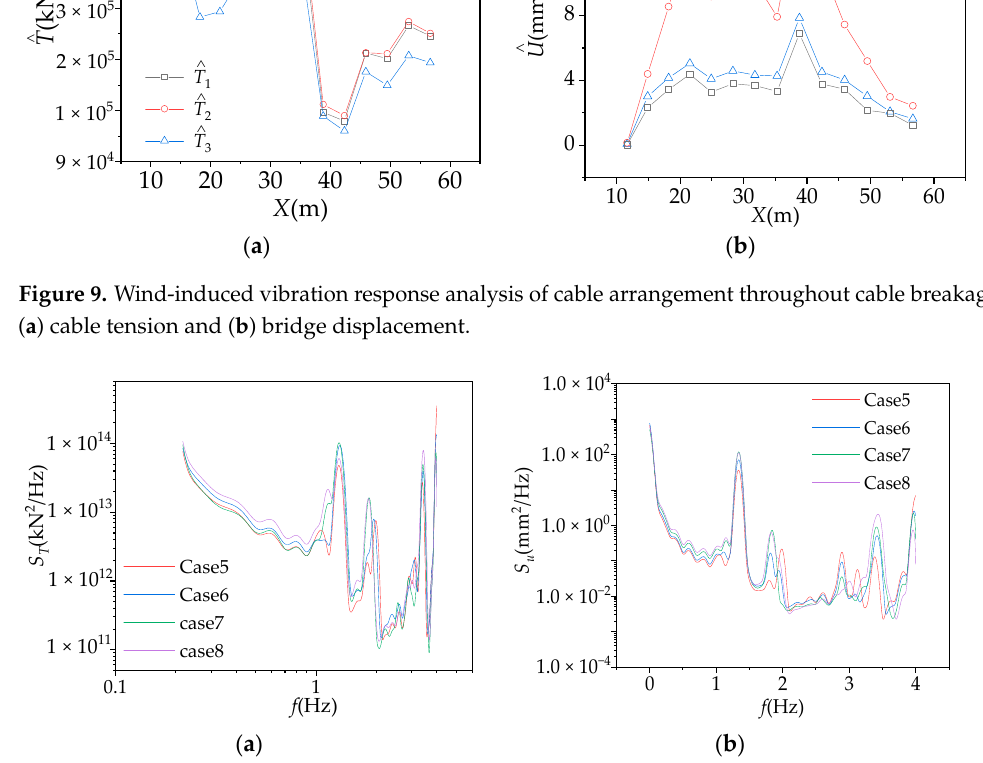
Figure 9. Wind ‐ induced vibration response analysis of cable arrangement throughout cable break ‐ age: ( a ) cable tension and ( b ) bridge displacement.